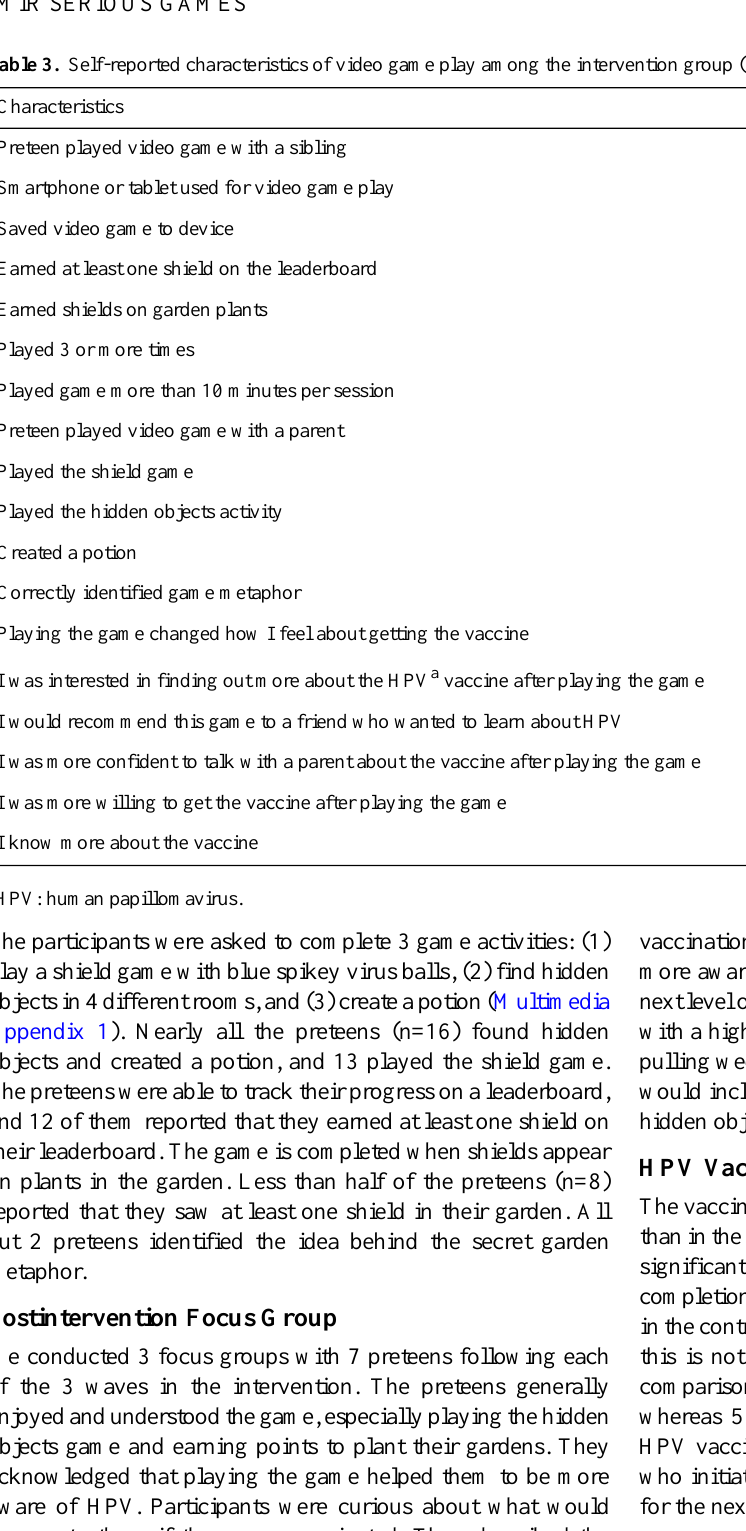
Table 3. Self-reported characteristics of video game play among the intervention group (18 preteens who played the game).